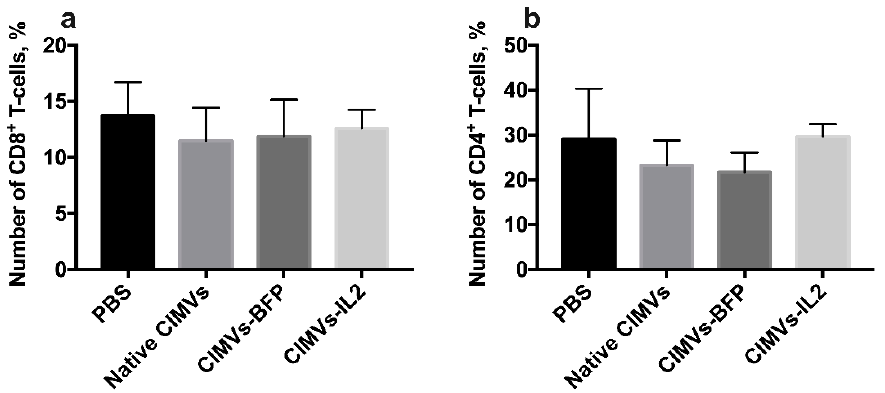
Figure 10. To analyze the effect of CIMVs-IL2 in in vivo, CD-1 immunocompetent mice were intra- venously injected with 50 µ g (in 200 µ L of PBS) of native CIMVs, CIMVs-BFP or CIMVs-IL2. After 72 h there was no statistically significant difference in the number of murine CD45 + CD3 + CD4 − CD8 + T-cells ( a ) as well as CD45 + CD3 + CD8 − CD4 + T-cells ( b ) after cultivation with CIMVs-IL2. Each box represents the mean ± SD ( n = 5) of five biological replicates, which are calculated as relative to control PBS group.